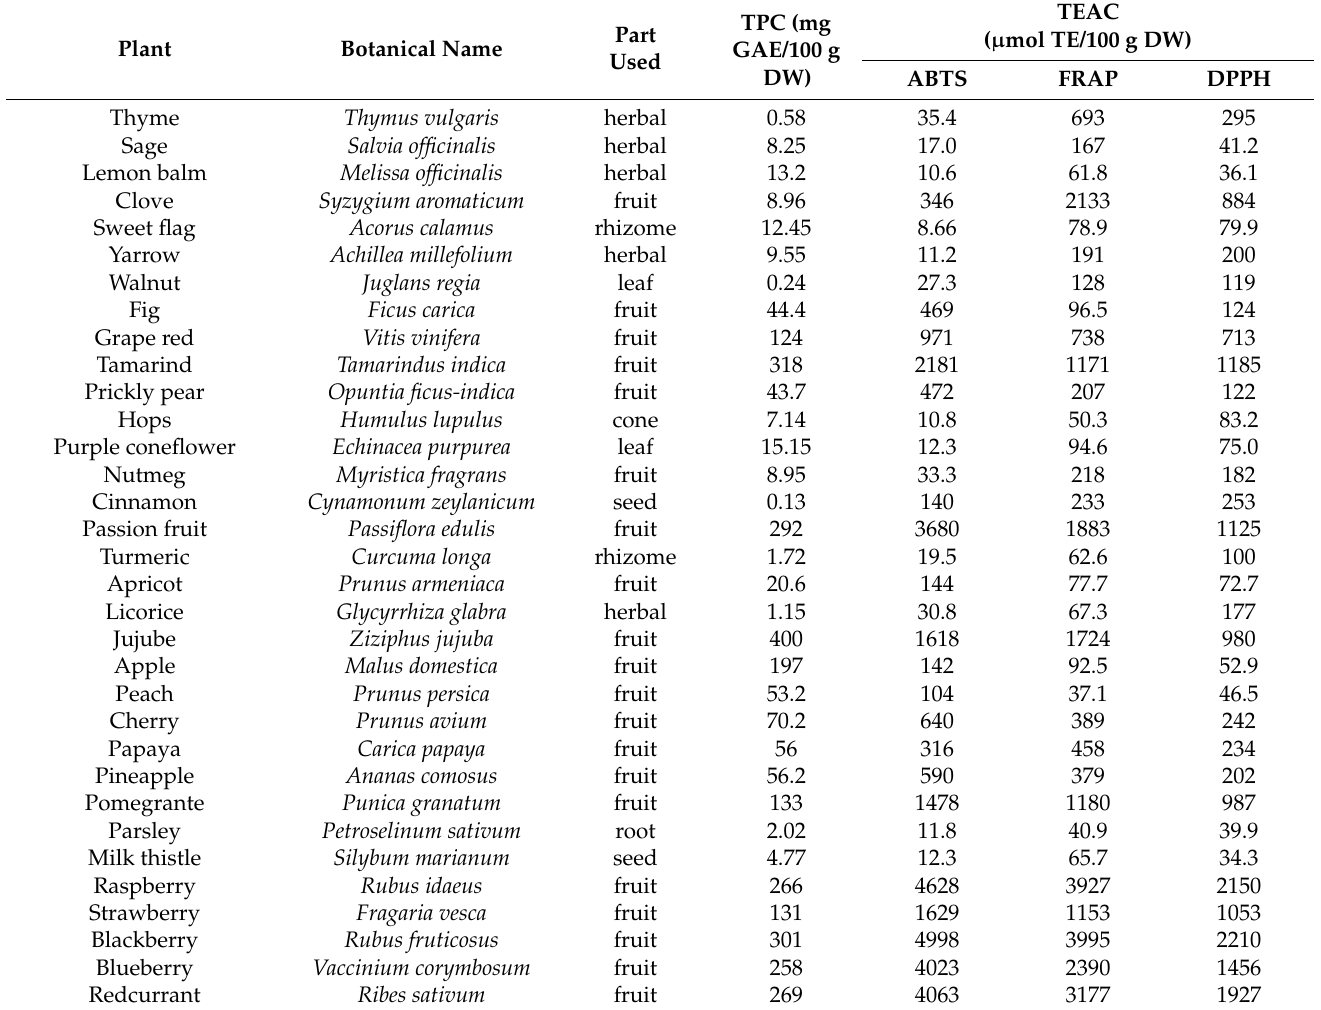
Table 3. Selected polyphenolic plant materials and their antioxidant properties [33,34]